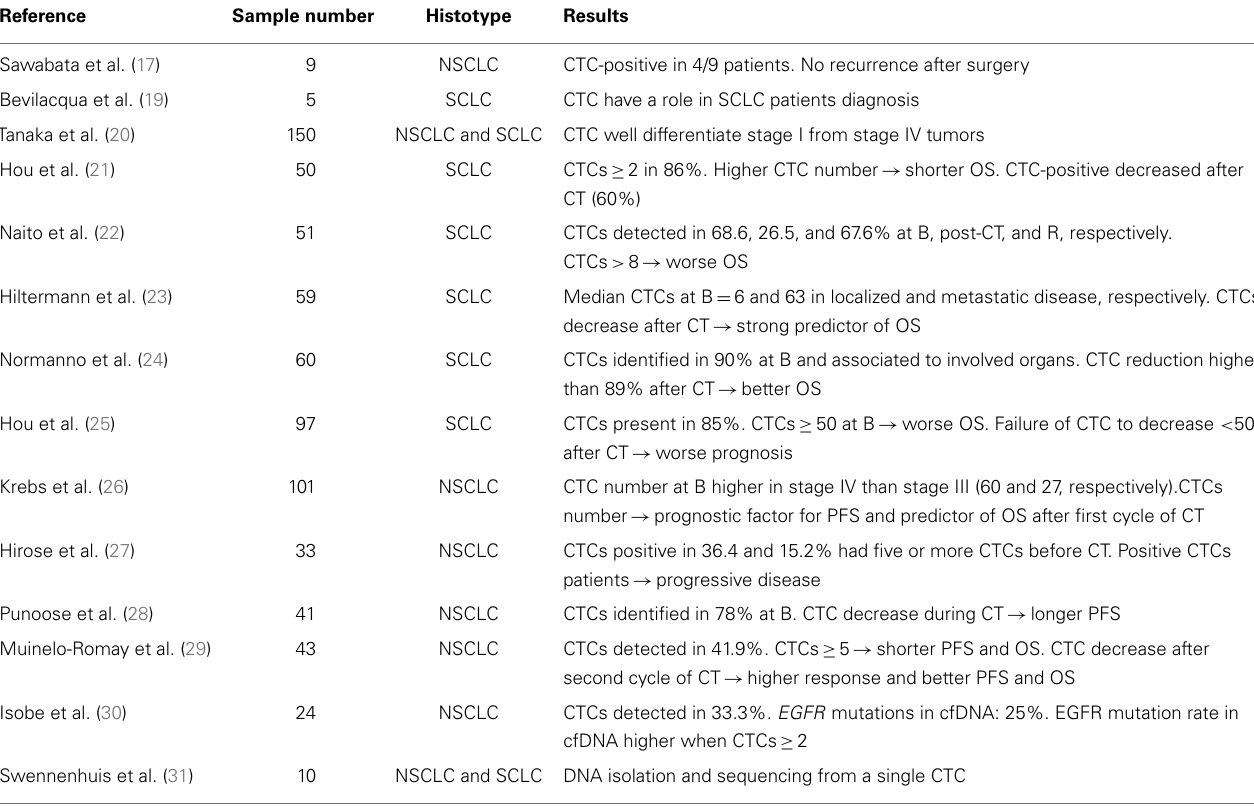
Table 1 | Summary of relevant results from CTC studies in lung cancer by CellSearch